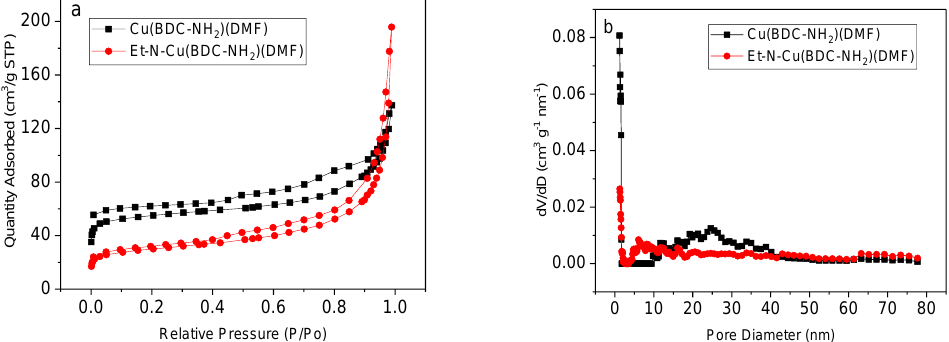
Figure 5. ( a ) Nitrogen adsorption–desorption isotherm of the prepared Cu(BDC-NH 2 )(DMF) and Et- N -Cu(BDC-NH 2 ) (DMF) samples. ( b ) Pore size distributions derived from NLDFT calculations. Table 1. Comparison of surface areas and total pore volums of Et- N -Cu(BDC-NH 2 )(DMF) and